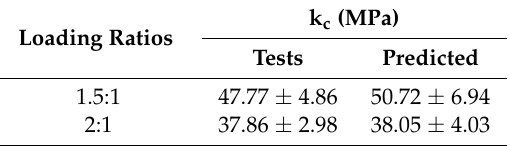
Table 4. Comparison of test results and predictive results under different ratios.